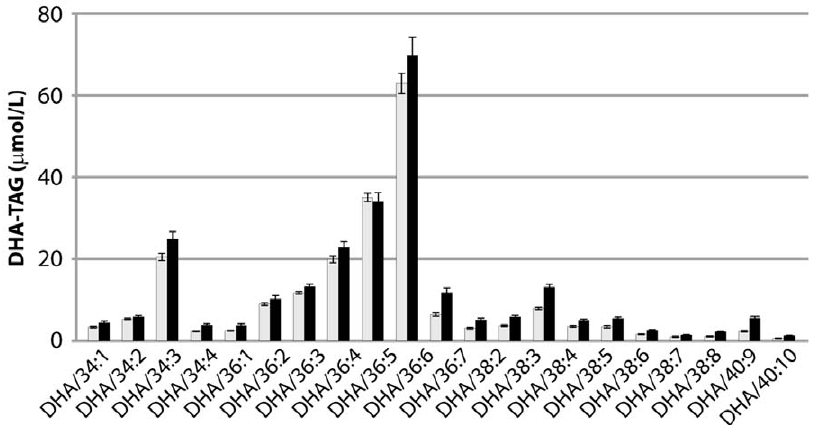
Figure 6. LC-MS analysis of major DHA-containing triacylglycerol species in transgenic Arabidopsisthaliana developing (grey) and mature (black) seeds. The number following the DHA denotes the total number of carbon atoms and total number of double bonds in the other two fatty acids.